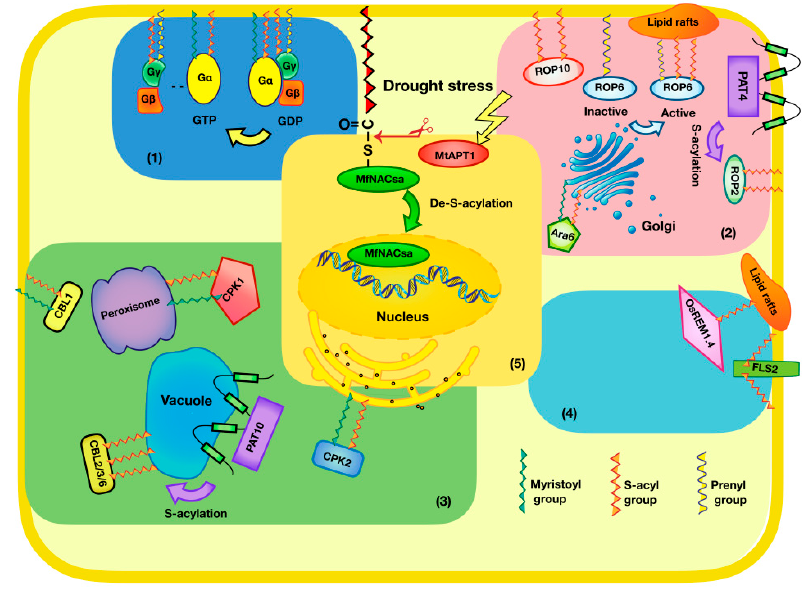
Figure 1. Some known S-acylated proteins in plants. S-acylation impacts a range of proteins with functions, including, heterotrimeric G protein subunits, small G proteins, proteins involved in Ca 2+ signaling, pathogenesis related proteins and transcription factors. (1) Heterotrimeric G protein subunits. Arabidopsis G α subunit, GPA1, is localized to the plasma membrane, depending on its myristoylation and S-acylation states. Arabidopsis G γ subunit, AGG2, has a prenylation and a S-acylation. Dual lipidation of G γ targets the G βγ dimer to the plasma membrane, where it can form a heterotrimer with G α . (2) Small G proteins. Inactive AtROP6 is only prenylated and accumulates in Triton-soluble membranes. Activated AtROP6 is subject to transient S -acylation and it accumulates in lipid rafts. ROP2 and ROP10 have two S-acylation cysteine residues. Protein S-acyl transferase 4(PAT4) may